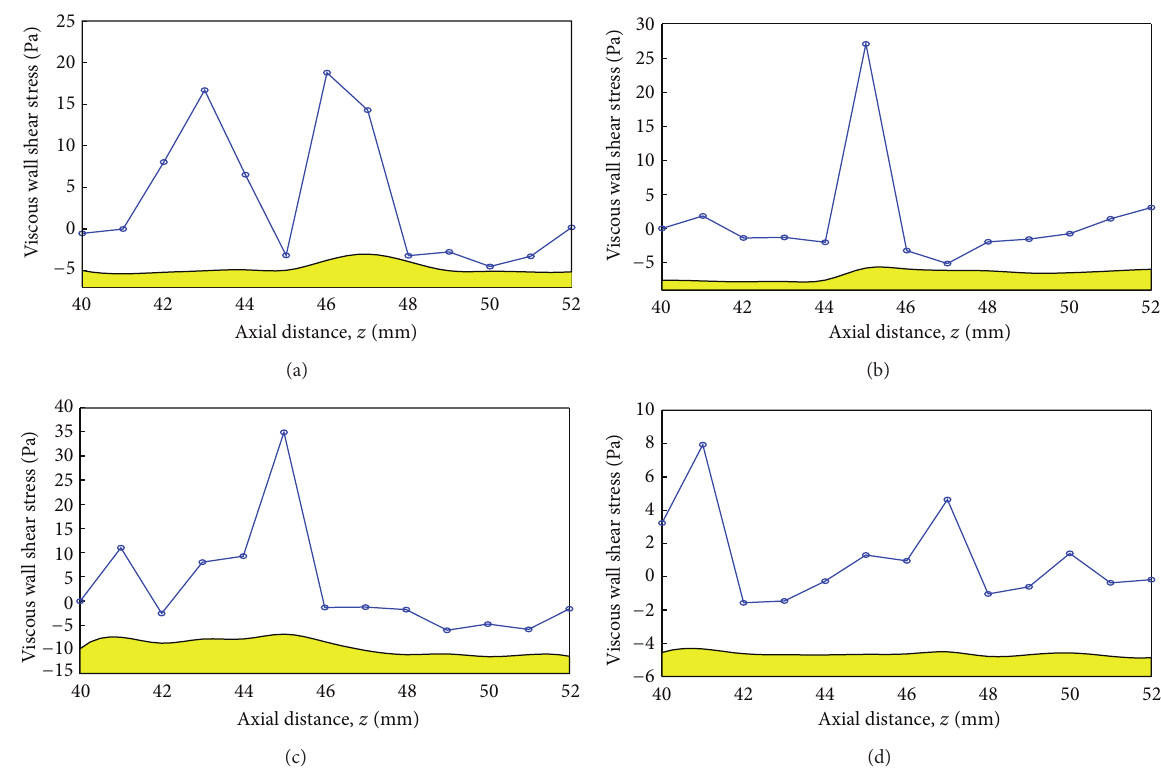
Figure 11: Variation of WSS (mean flow direction) along the wall at time corresponding to peak systole ( 𝑄 max ) for (a) Type I, (b) Type II, (c) Type III, and (d) Type IV. Flow is from left to